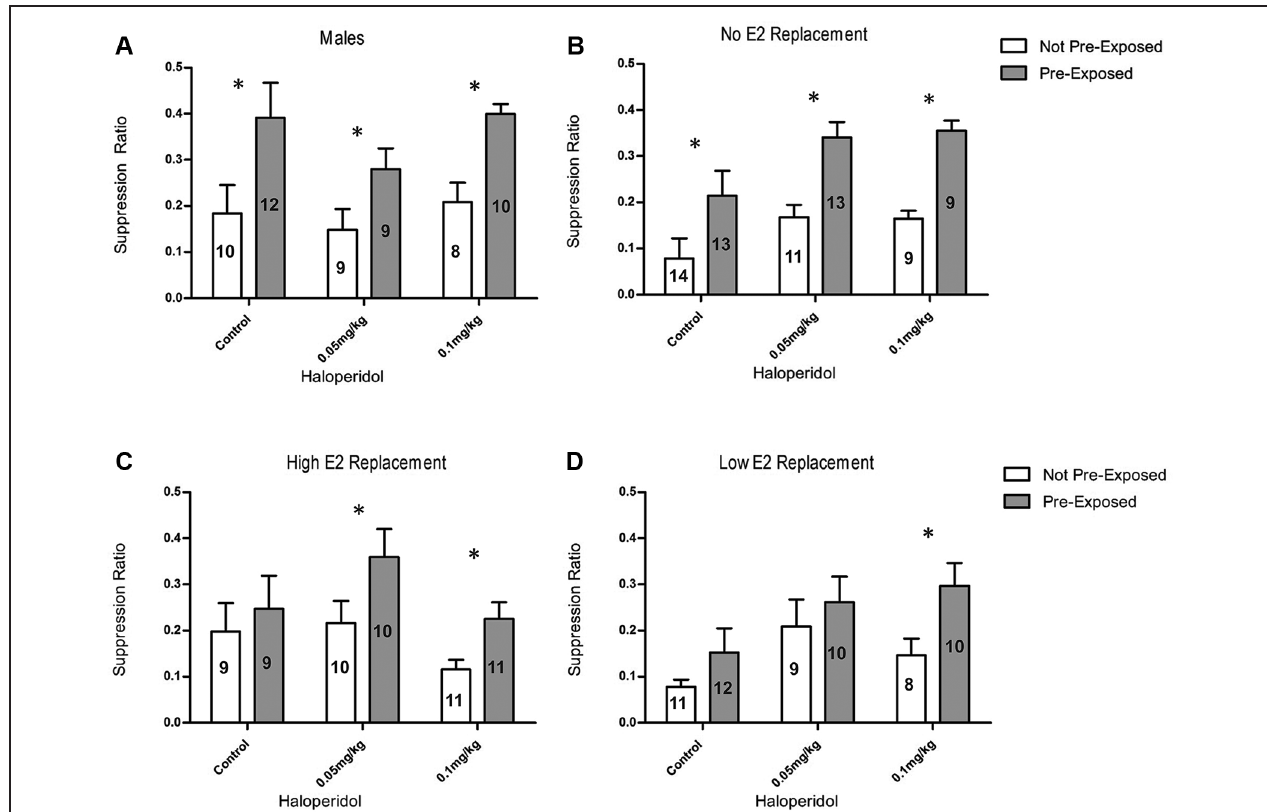
treated with 0.05 mg/kg and 0.1 mg/kg HAL. (D) Suppression ratios for OVX females receiving low E2 replacement: LI was observed in rats treated with the 0.1 mg/kg HAL. The error bars represent standard error of the mean, the n for each group is depicted on the bar representing that group. (* = p <